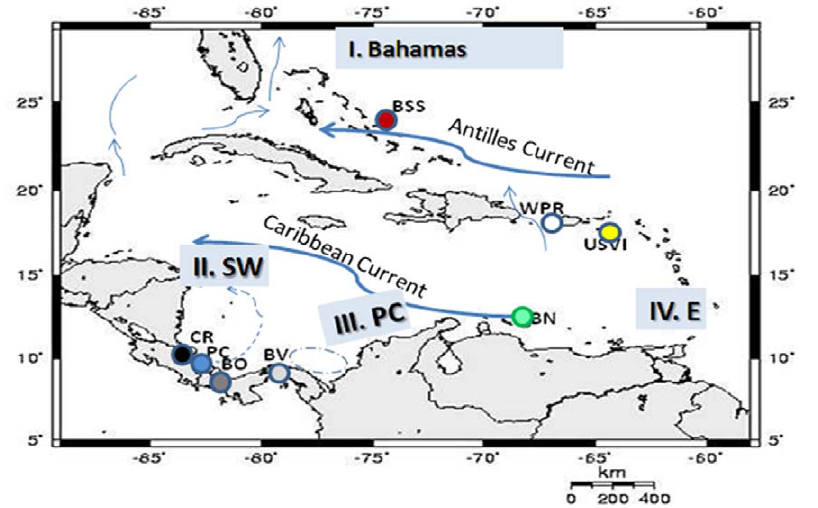
Figure 1. Sampling locations and regions for C. pica in the Caribbean. Region I- Bahamas [ BSS: San Salvador Bahamas], Region II- Southwestern SW [ CR: Punta Cocles, PC: Playa Chiquita, BO: Bocas del Toro], Region III-Panama central PC [ BV: Buenaventura-Colon-Panama], Region IV- Eastern E [ BN: Bonaire, USVI: Virgin Islands, WPR : Puerto Rico (Guajataca, Aguadilla and La Parguera)].